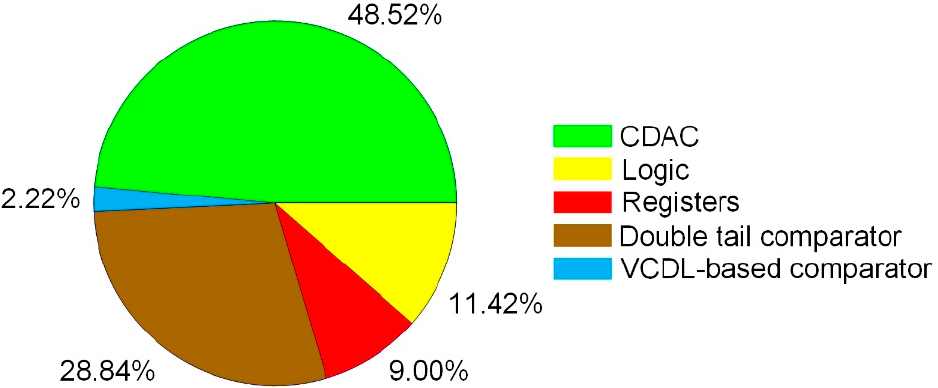
Figure 17. Power breakdown of the proposed SAR ADC.